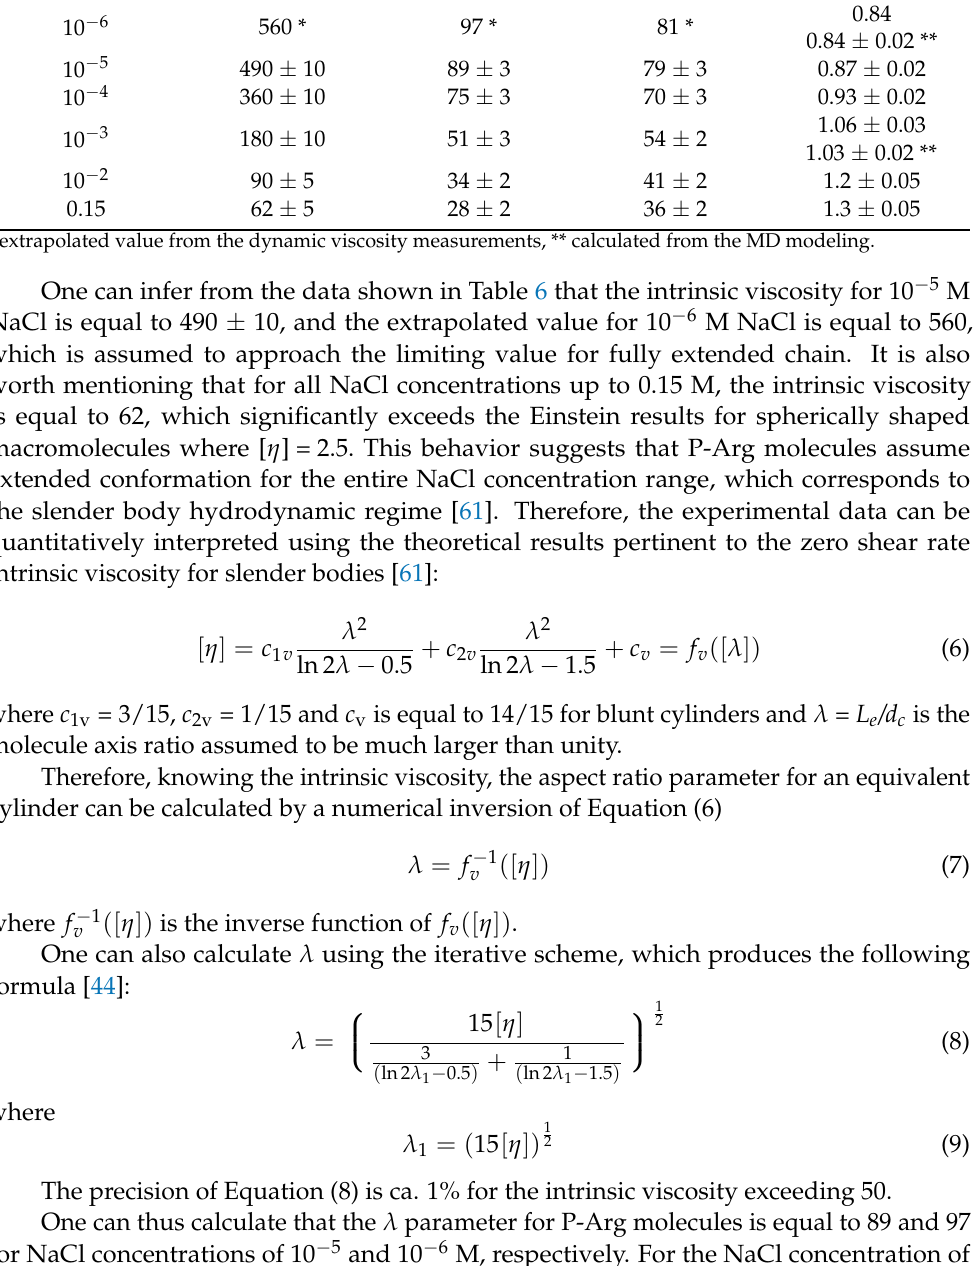
Table 6. The intrinsic viscosity [ η ], the λ = L e /d c parameter, the equivalent cylinder chain diameter d c , the cylinder lengths L c of the P-Arg molecules for various ionic strengths derived from viscosity and DLS measurements (pH 5.6). c NaCl [ η ] L c λ [M] [1] [1] [nm]